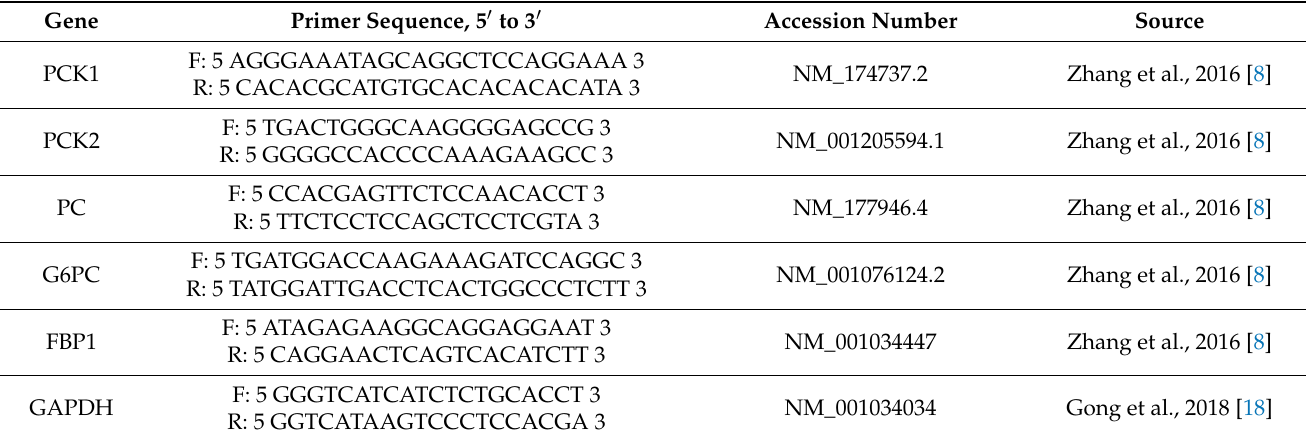
Table 1. Primers for real-time PCR